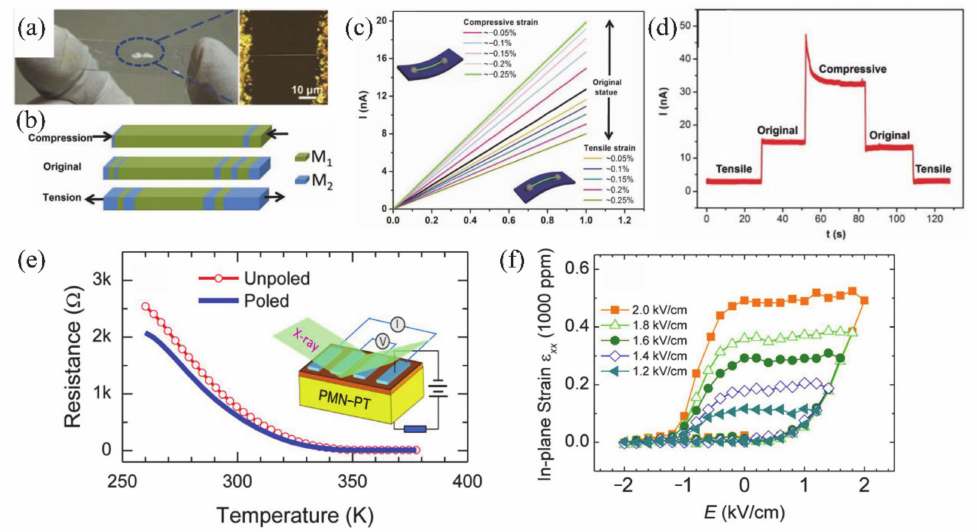
Figure 24. ( a ) As-fabricated strain sensor device and the corresponding optical image. ( b ) Schematic of the phase transitions of M1 and M2 with tensile and compressive strains. ( c ) The I–V curve under different tensile and compressive strains. ( d ) Fast response to the strain switch. Reproduced from [175], with permission from John Wiley and Sons, 2010. ( e ) Temperature- dependent resistance curves of VO 2 film under the unpolarized and polarized states, and the inset shows a schematic of the VO 2 /PMNPT (111) structure. ( f ) In-plane strain for the VO 2 /PMNPT heterostructure under different electric fields. Reproduced from [144], with permission from American Chemical Society,